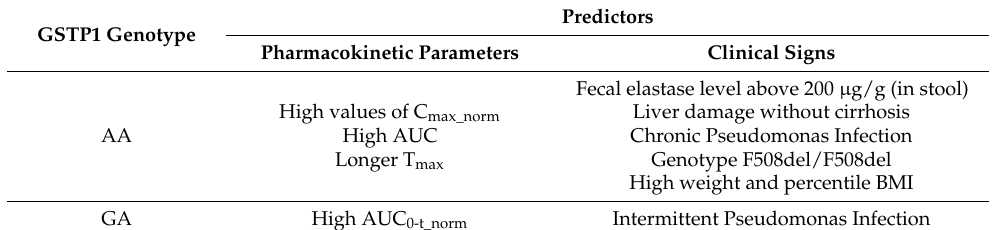
Table 13. Relationship between pharmacokinetic parameters, clinical signs and genotypes of the GSTP1 gene.